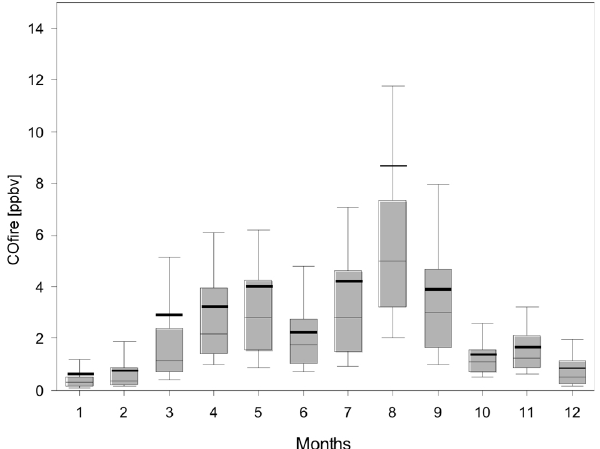
Fig. 2. Monthly distributions of FLEXPART CO fire at ICO-OV dur- ing the period January 2007–July 2009. The boxes and whisker de- note the 10, 25, 50, 75 and 90 percentiles. Bold lines represent av- erage